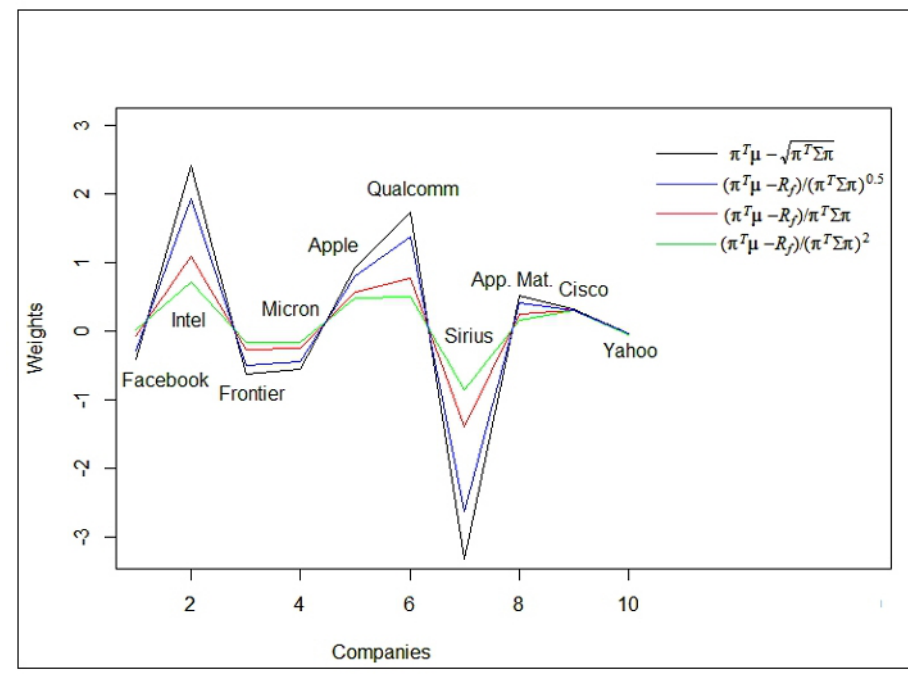
Figure 2. Optimal portfolios for Mean standard deviation (MSD) and generalized Sharpe ratio, β = 0.5,1,2, utility